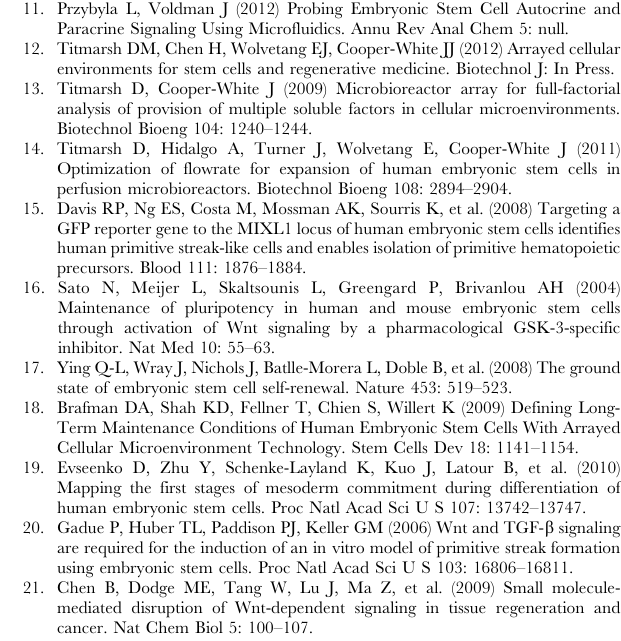
Figure S8 Gene expression profiling of MIXL1-GFP-sorted populations. ( a ) Cell sorting strategy. Live, single cells were identified using FSC and SSC area and width parameters and propidium iodide exclusion, and then the top 10% and bottom 20% of cells in terms of GFP-expression were sorted into separate fractions. ( b ) RT-qPCR quantification of gene expression in control (uninduced, unsorted) and 2 d induced, MIXL1-GFP- sorted cell populations. Bars represent mean 6 s.e.m. ( n = 6 from 3 independent sorts) of gene expression relative to GAPDH , normalised to undinduced samples. * indicates p , 0.05, one-way ANOVA. Relative to uninduced cells, induced cells showed upregulation of mesendodermal markers T and MIXL1 , soluble Wnt molecules WNT3A and WNT8A , and the soluble Wnt antagonist DKK1